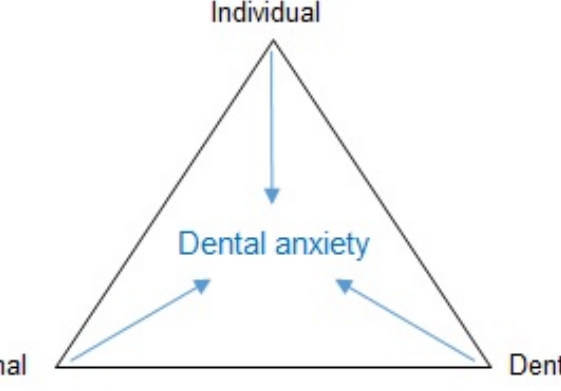
Figure 2. Aetiological model of dental anxiety [5]. Figure 1. Intuitive analysis of the development of dental anxiety [1].